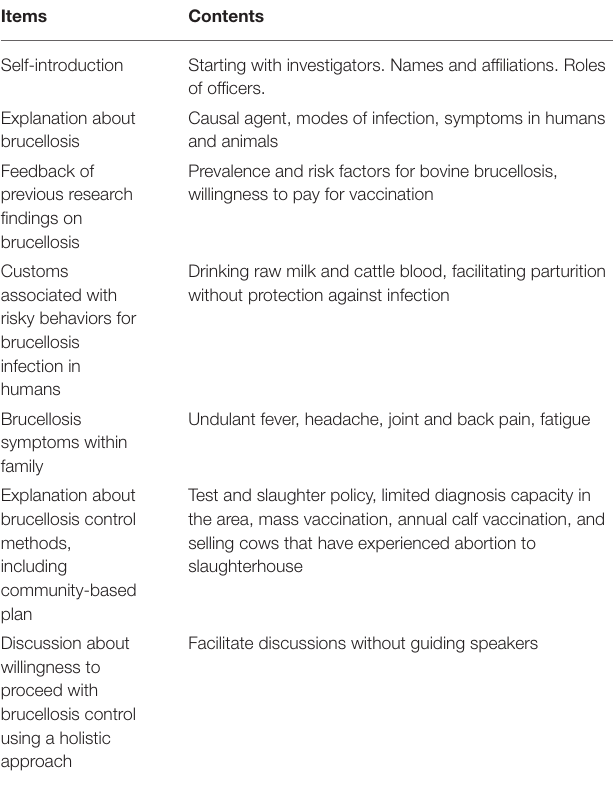
TABLE 1 | Checklist used for the PRAs in this